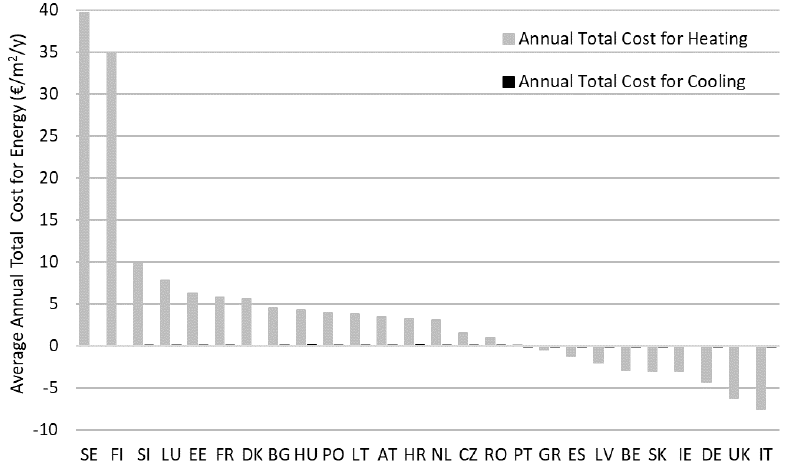
Figure 5. Average unit cost for heating and cooling with combined cooling heat and power (CCHP) (average values for the 2008–2018 period).